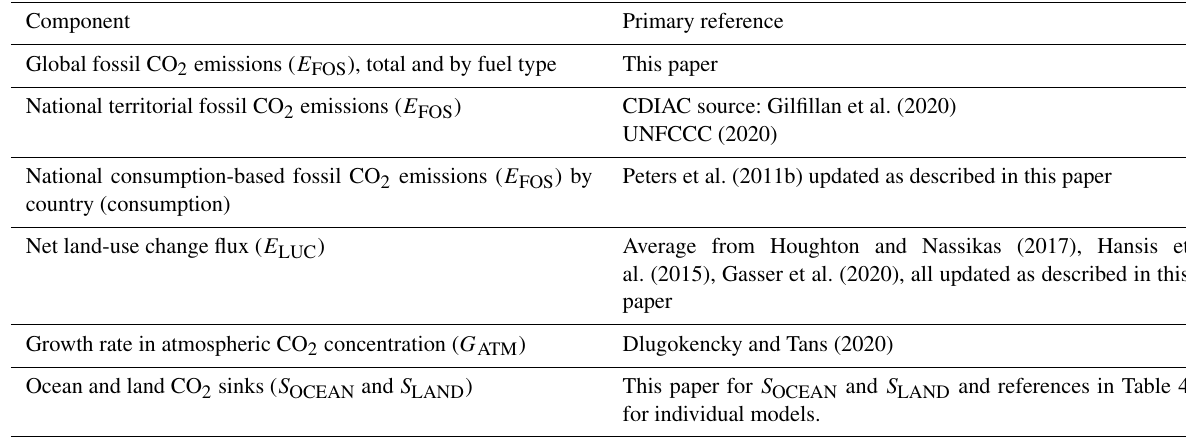
Table 2. How to cite the individual components of the global carbon budget presented here.